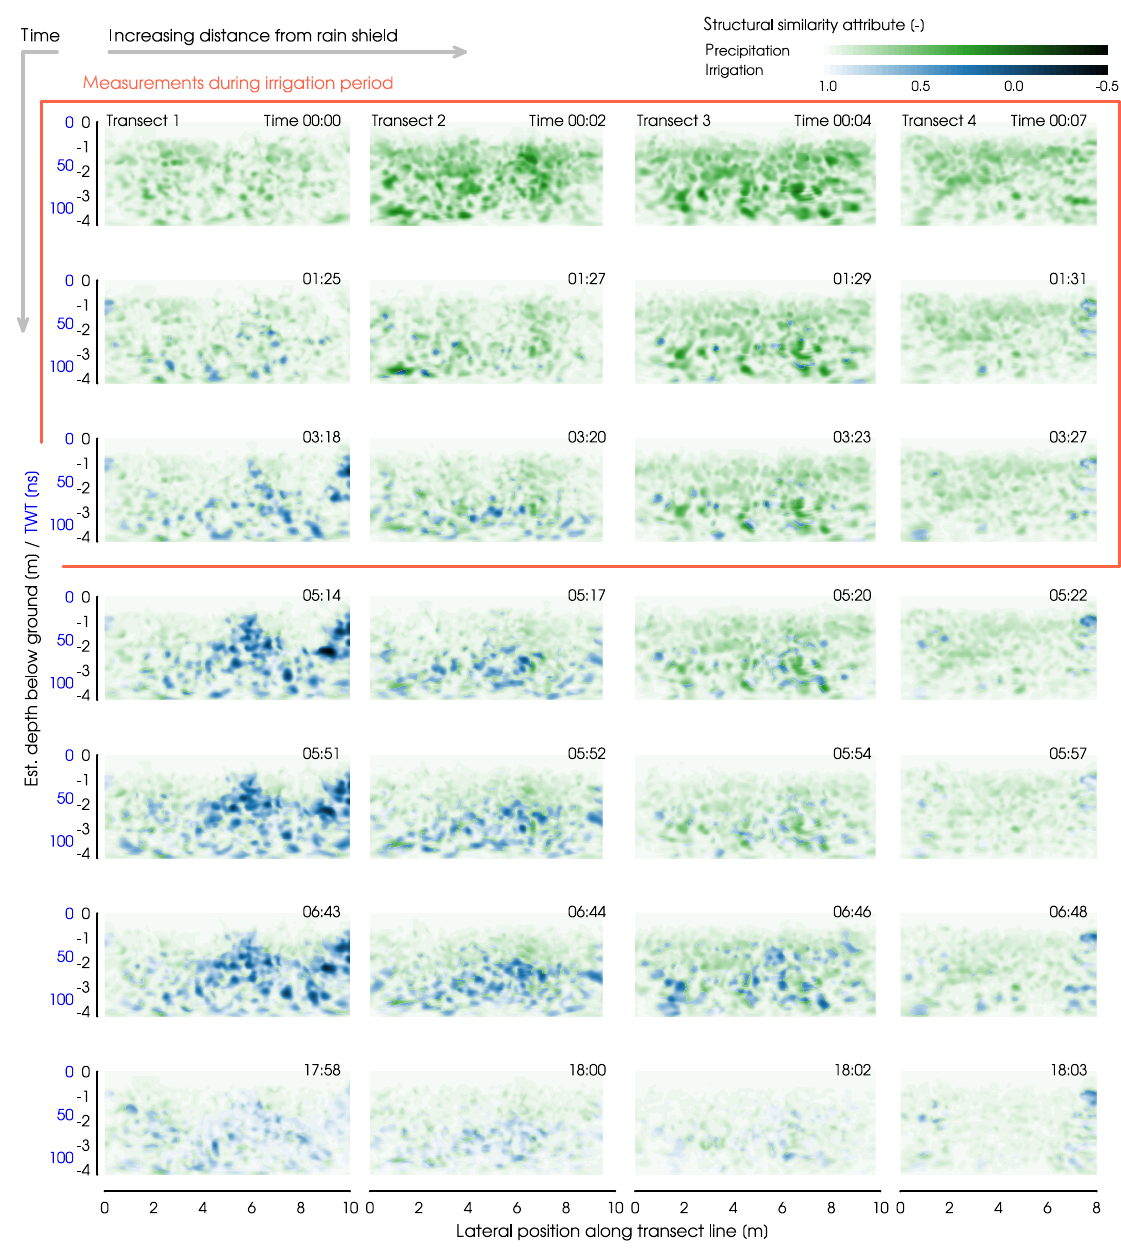
Figure 9. Structural similarity attributes calculated from time-lapse GPR data. All measurements were referenced to the last one 24:00h after irrigation start, indicating changes in the GPR reflection patterns associated with soil moisture changes. A structural similarity attribute value of 1 indicates full similarity; lower values signify higher deviation from the reference state. Water from the preceding natural rain event (green) was identified by constant or increasing structural similarity attributes. Water from the experimental irrigation (blue) was identified by decreasing values after irrigation start by more than 0.15. Within one column the rows give a sequence over time (after irrigation start). Columns proceed downhill, with increasing distance from the rain